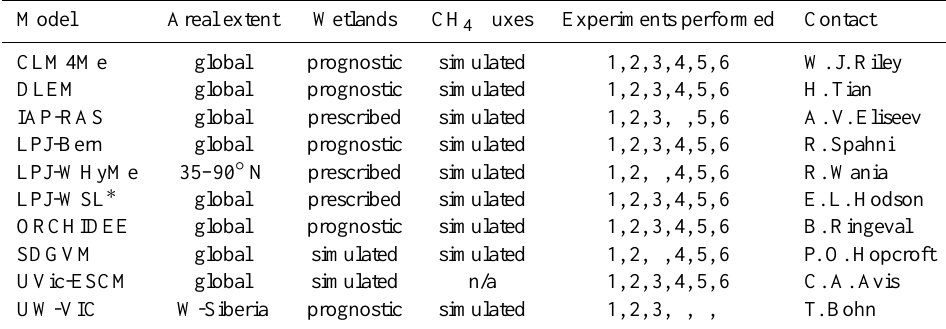
Table 2. List of experiments (described in Table 1) performed by each of the participating modelling groups. “Prognostic” indicates that a model located at least part of its wetlands based either on an inversion to GIEMS and modelled hydrological state or used GIEMS as a spatial or temporal constraint. “Prescribed” means that the model used a distribution map for wetlands and “simulated” means that the model did not input any kind of wetland observational data to locate wetlands (see Sect. 4.1).